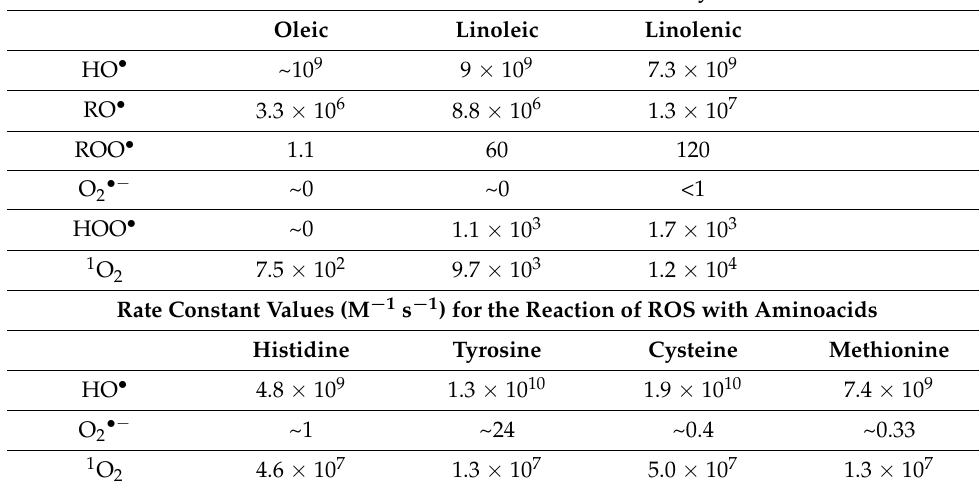
Table 3. Values of the rate constants for the reaction of ROS with some fatty acids and amino acids. Data from refs.